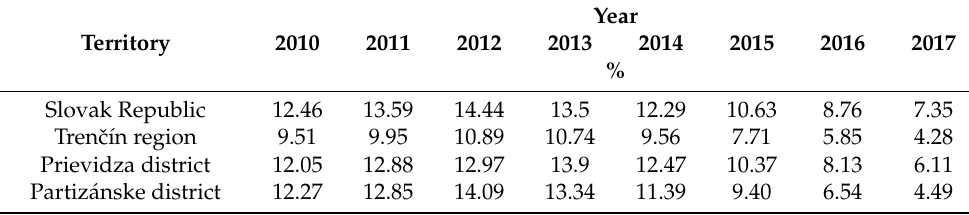
Table 1. Unemployment trend in Slovakia and Upper